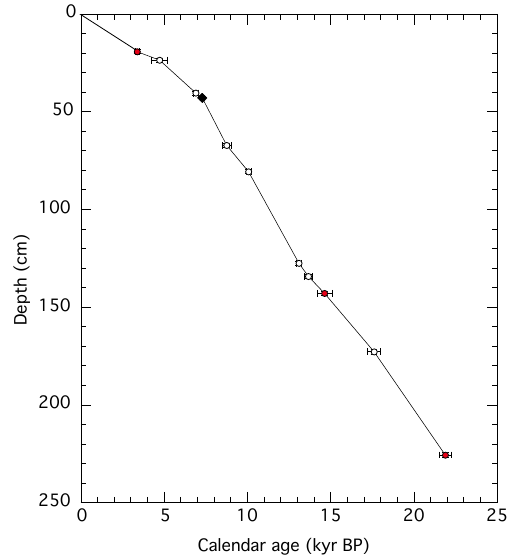
Figure 4. Age model of GH08-2004. Open symbols represent the 14 C data and 2 σ errors. The filled symbol represents the K–Ah tephra. Red circles indicate 14 C ages from deeper-dwelling planktic